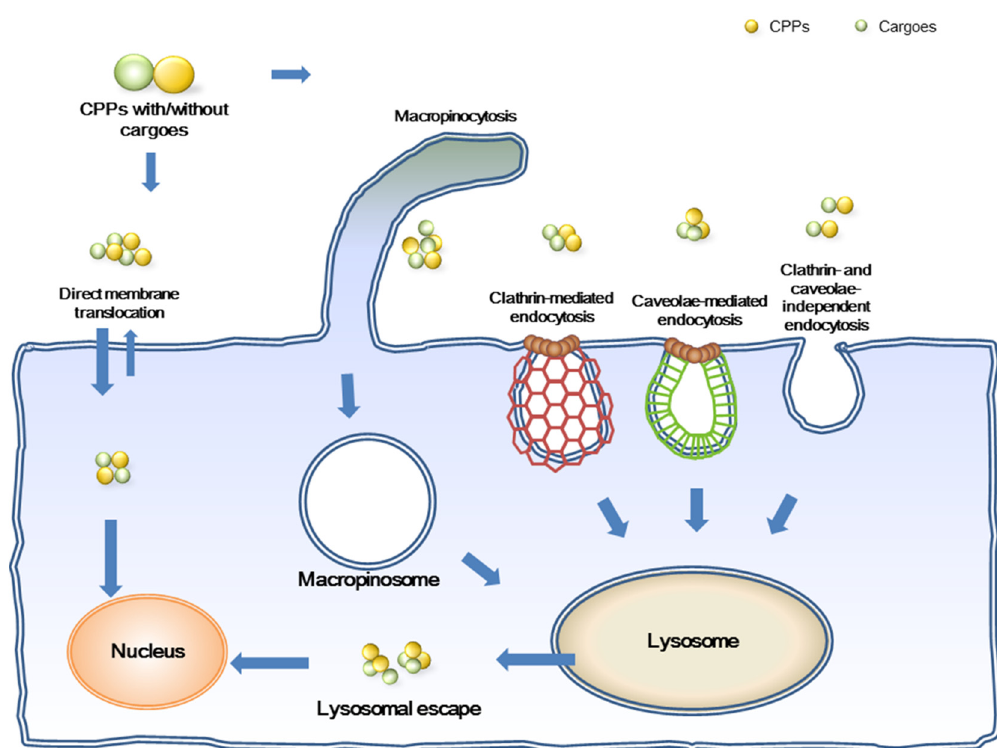
Figure 1. Different cellular entry routes for either cell-penetrating peptides (CPPs) alone or CPP/cargo complexes. Direct membrane translocation and endocytosis are two major routes which have been proposed. Endocytic pathways are further divided into four categories: macropinocytosis, clathrin-mediated endocytosis, caveolae-mediated endocytosis, and clathrin- and caveolae-independent endocytosis.